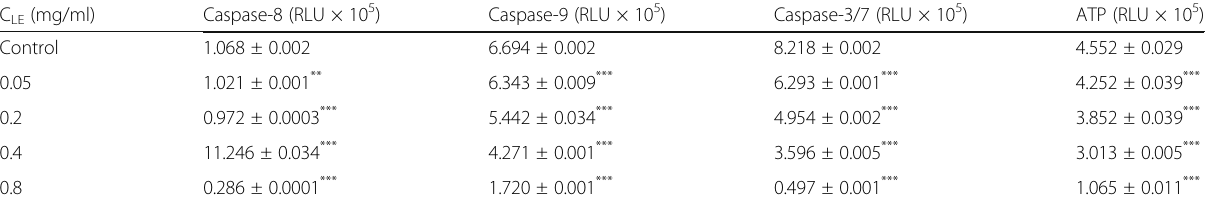
(Values expressed as mean ± SD, ** p < 0.001, *** p < 0.0001 compared to the